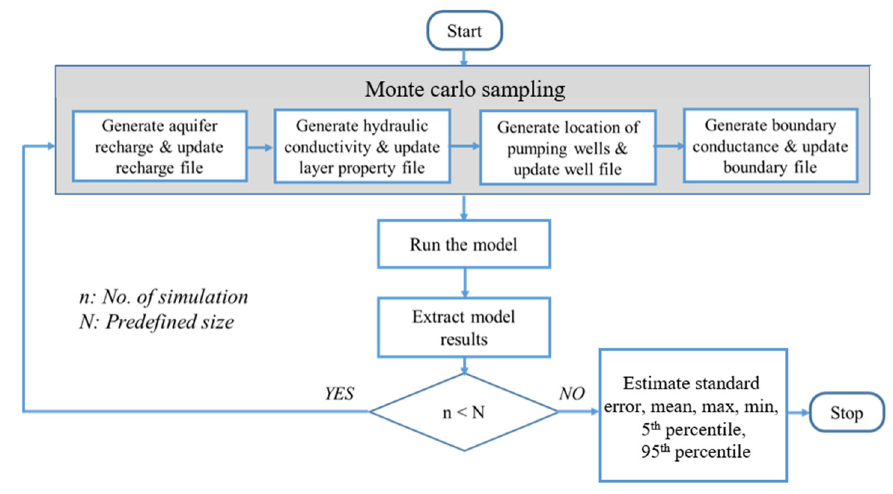
Figure 9. Flow chart for uncertainty analysis using predefined sample size N .